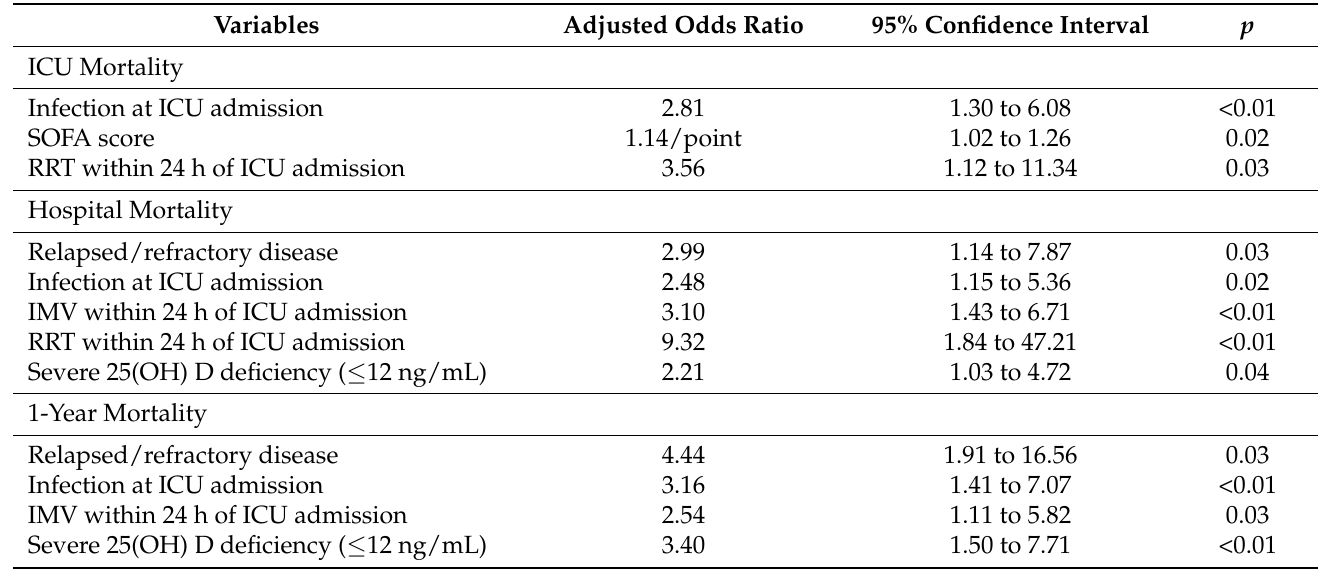
Table 4. Multivariate logistic regression analysis regarding survival